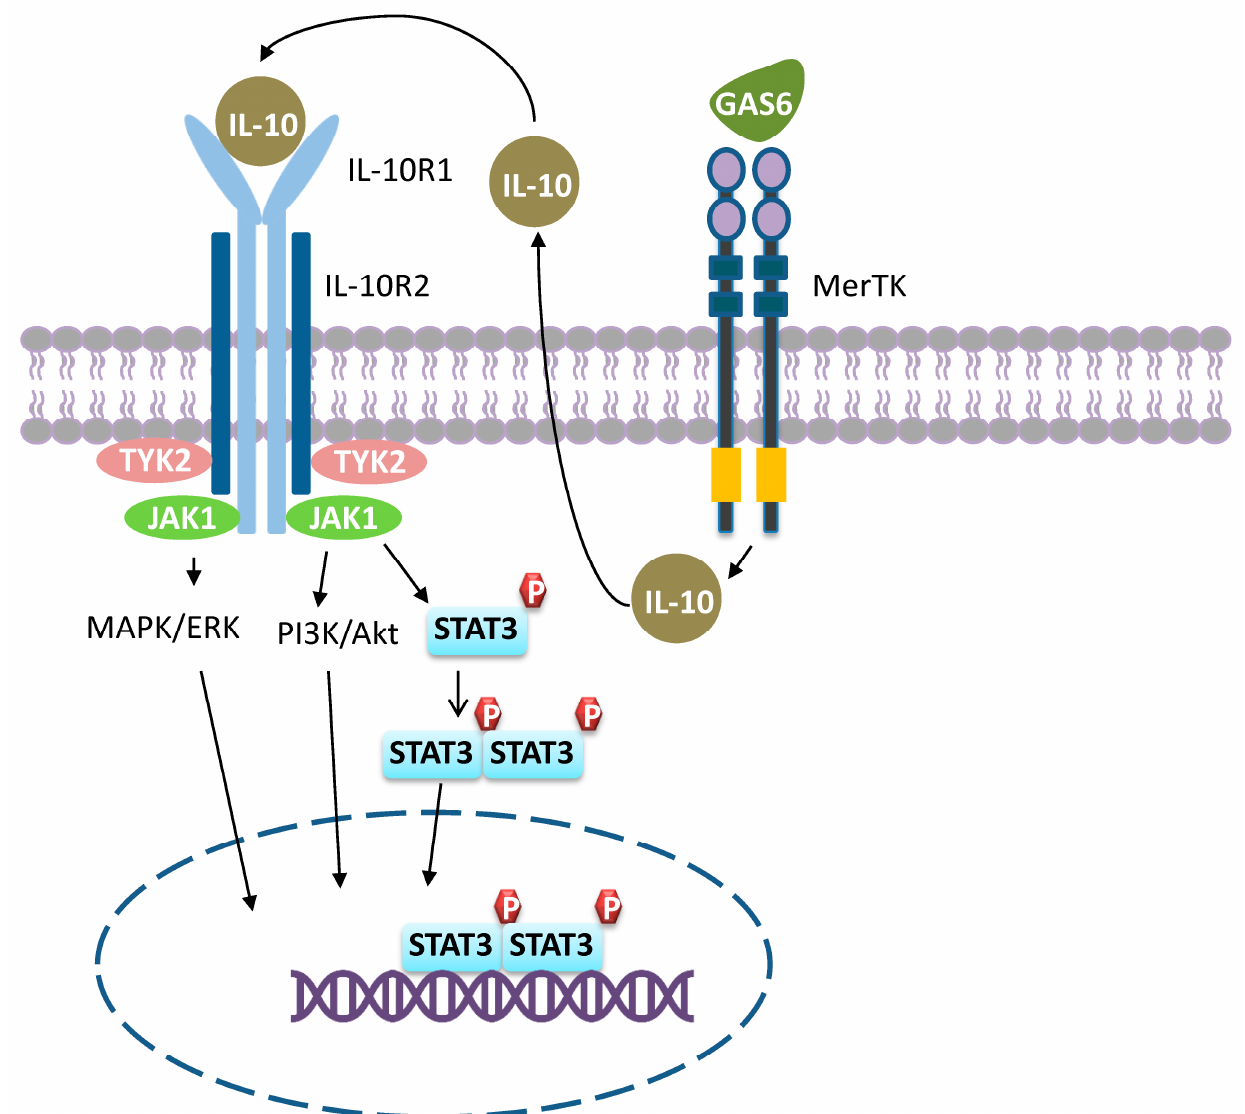
Figure 3. M2c polarization. M2c macrophages polarize through signaling pathways mediated by STAT3, MAPK/ERK, and PI3K/Akt. Engagement of GAS6 produced by M2c with MerTK induces IL-10 production, which in turn activates M2c, resulting in a positive loop that favors M2c polari- zation.